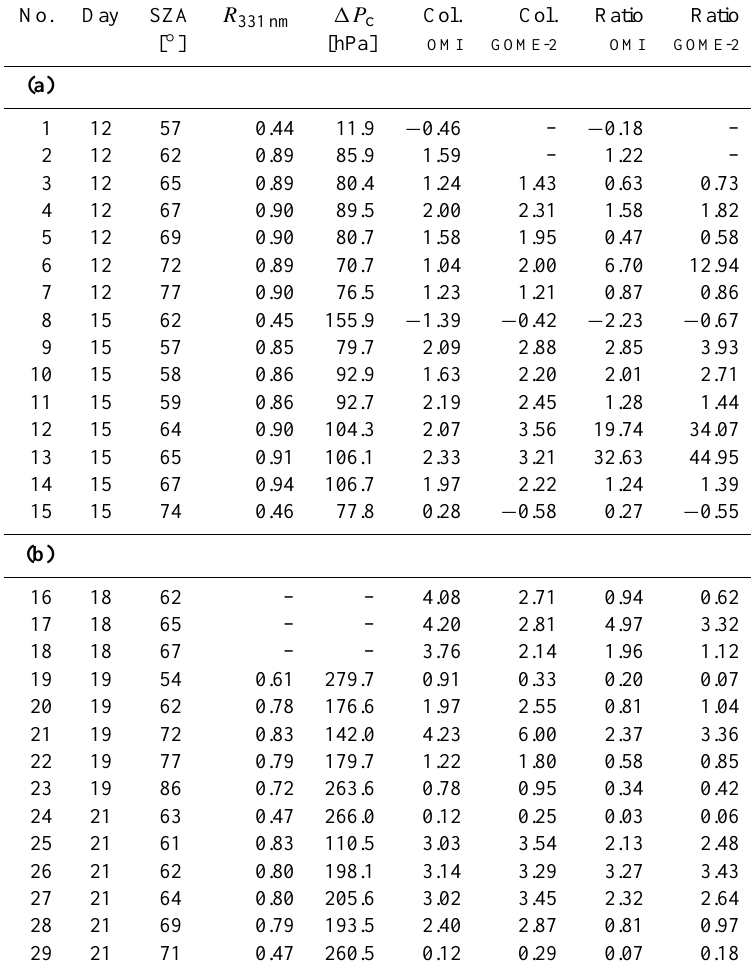
Table 4. Similar to Table 3 but for NOAA WP-3D profiles of BrO, measured on (a) 12 to 15 April 2008, (b) 18 to 21 April